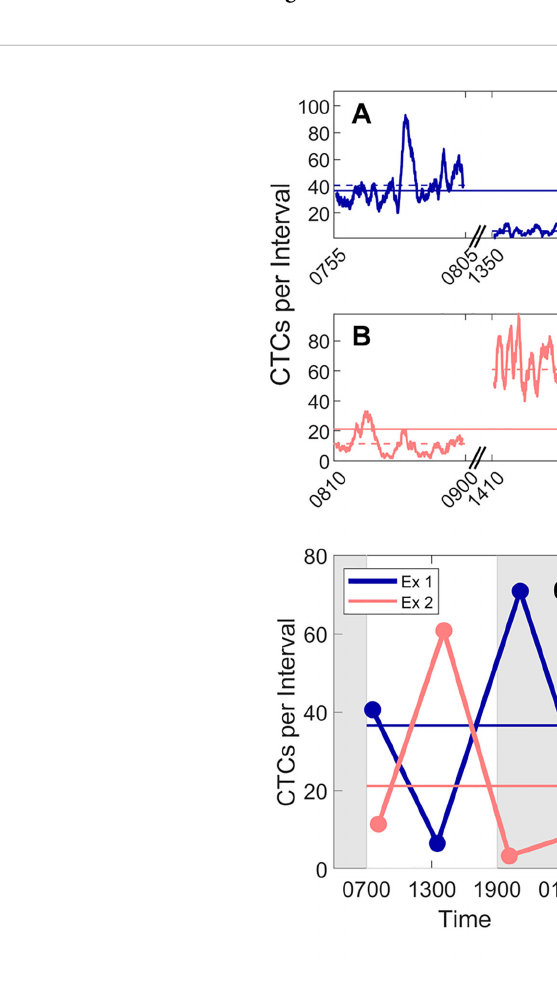
FIGURE 5 | Large fl uctuations in CTC numbers were observed over 24-h cycles. (A, B) Example DiFC measurements taken over 24 h in two MM-bearing mice. The number of CTCs counted in 2 min (5% PBV) sliding intervals is shown. The solid horizontal lines in each fi gure show the 24-h mean number of CTCs per 2 min interval, and the dashed horizontal lines show the local mean of the 50-min DiFC scan. Dark hours are shaded gray. (C) The mean DiFC count rates over the 24-h period are shown. (D) Ratios of maximum-to-minimum DiFC count rates are shown for MM 24-h, MM 35-min (no repositioning), 1-operator-with-reposition, and 2- operators-with-reposition data sets. Bars represent the mean values with standard deviation error bars and dotted lines to identify the median values. Note the logarithmic y-axis. Kolmogorov-Smirnov test signi fi cance indicated by ** (p-value < 0.01) and *** (p-value <